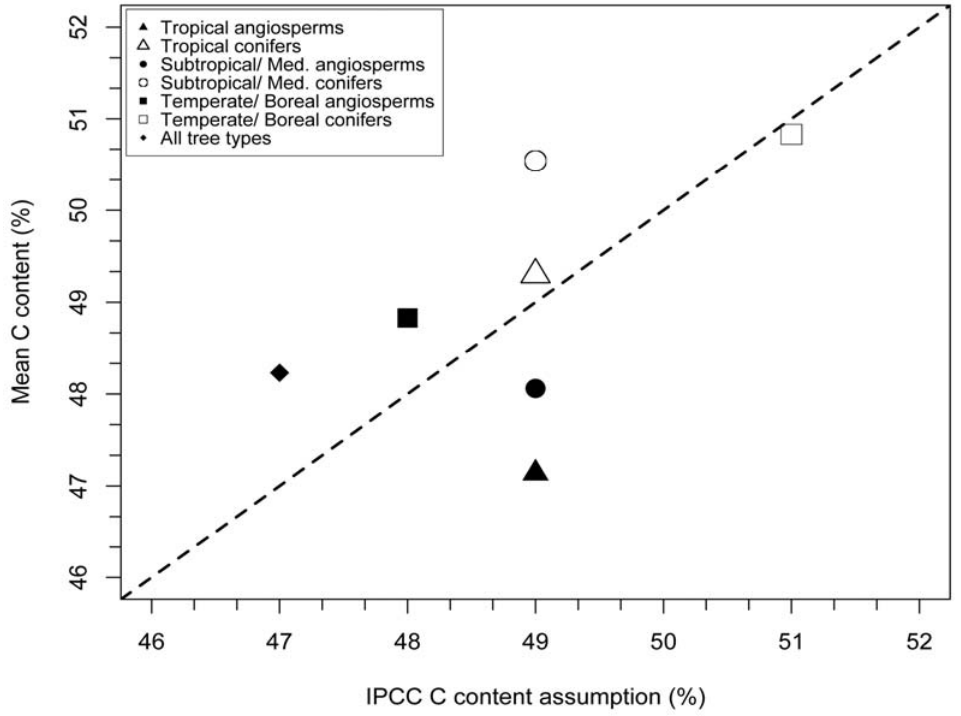
Figure 2. Comparison of wood C fractions suggested by IPCC forest C accounting protocols [30], and mean wood C data found through our literature review (Tables 1 and 2). Comparisons are presented for tropical (triangles), subtropical/Mediterranean (circles), and temperate/boreal (squares) biomes, grouped by angiosperms (filled symbols) and conifer species (open symbols). Also presented is a general value (closed diamond), corresponding to the “default value” suggested by the IPCC [30], and the grand mean calculated from N = 253 species found in the literature (Tables 1 and 2). Dashed line represents a 1:1 relationship between IPCC values and observed wood C content (where y intercept = 0 and slope = 1): a linear expectation (where y intercept = 0 and slope = 1) did not fit the relationship ( F = 0.499, p = 0, 7